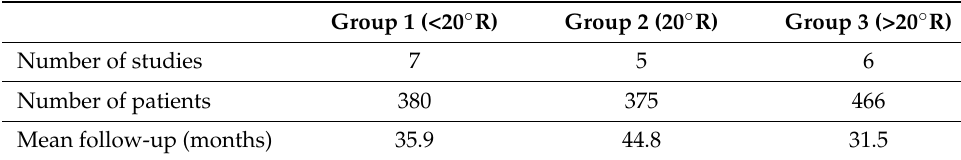
Table 2. Overview of demographics of three groups.